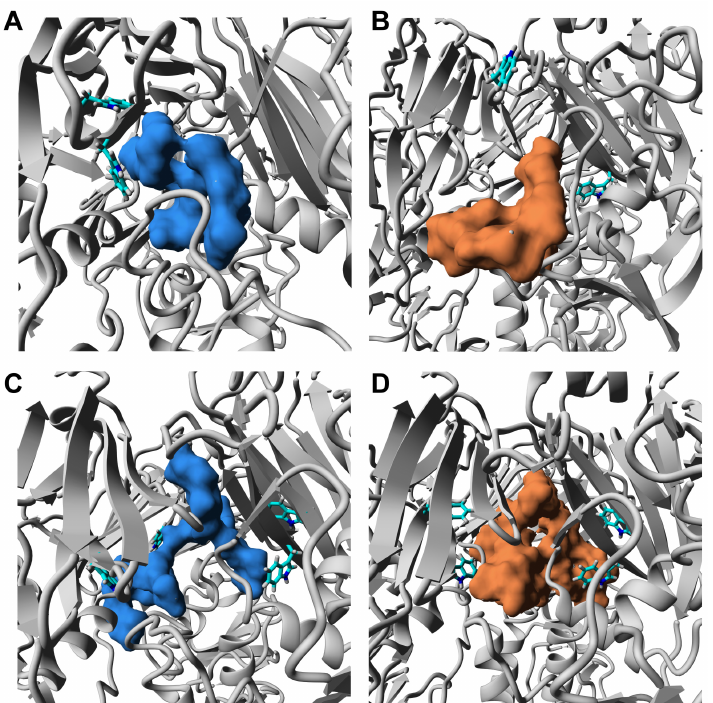
Figure 6. Close view position of the ORNs and ORNs-D-M ligands which non-specifically bind to the RBD domain. The HA3 complex with A3-ORNs ( A ), A3-ORNs-D-M ( B ), A6-ORNs ( C ), and A6-ORNs-D-M ( D ) ligands. The ORNs and functionalized ORNs-D-M ligands are highlighted as blue and brown, respectively. The side-chain of tryptophans (Trp180, Trp234) in HA 1 subunits, detected as a part of the binding interface, are shown as a stick.